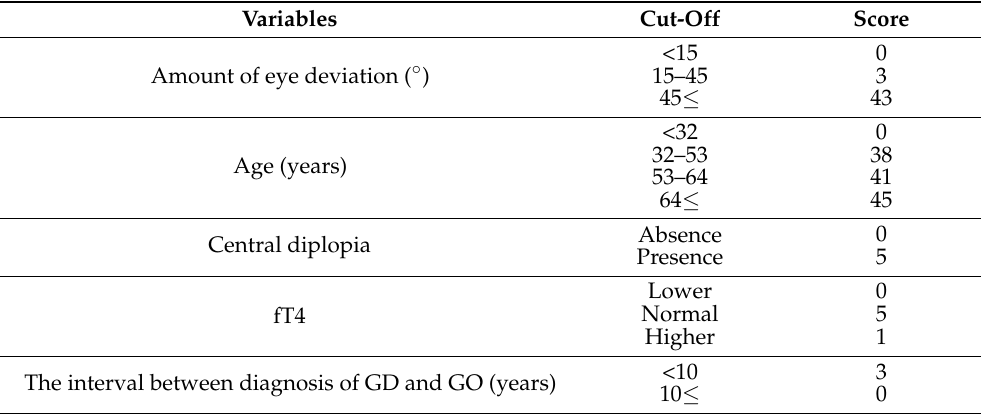
Table 3. The Score for Muscle predominant type of Graves’ orbitopathy Risk Prediction (SMGOP) according to important